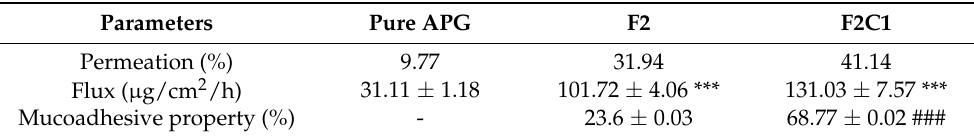
Table 3. Permeation profiles and mucoadhesion results of apigenin-loaded bilosomes (F2) and chitosan-coated apigenin-loaded bilosomes (F2C1). Results depicted as means ± SDs ( n = 3). Tukey Kramer test was used to compare different groups. *** highly significant compared to pure APG, ### significant compared to